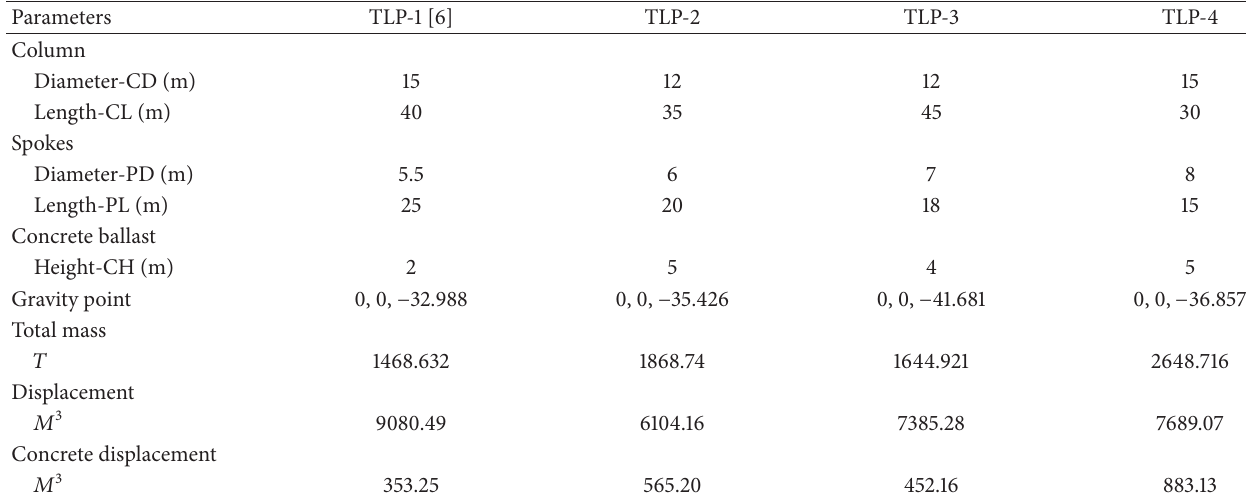
Table 2: Dimensions of four modified NREL-TLPs (see also Figure